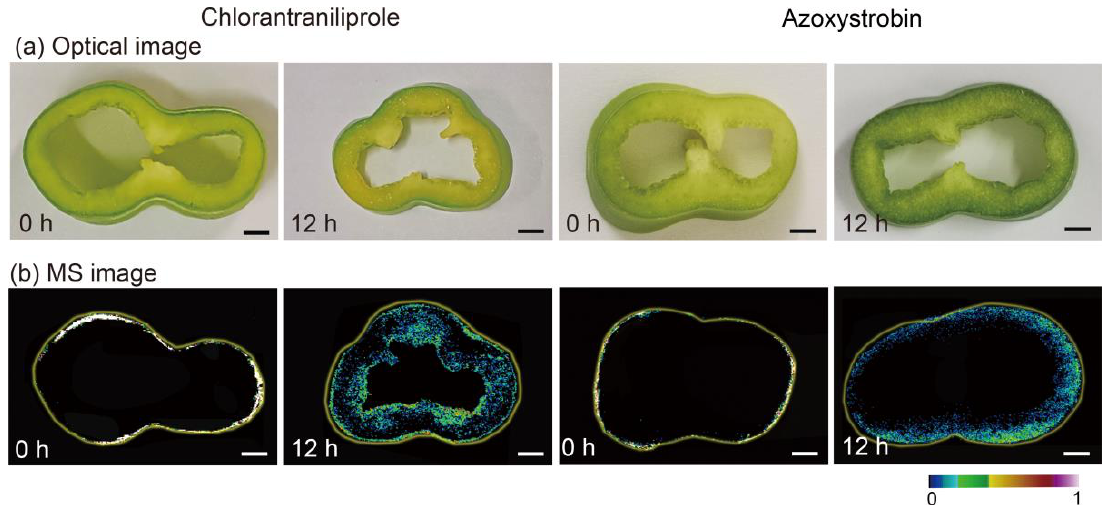
Figure 6. ( a ) Optical images and ( b ) MS images of pepper slices 0 h and 12 h after the application of chlorantraniliprole and azoxystrobin. Scale bar of 3 mm.